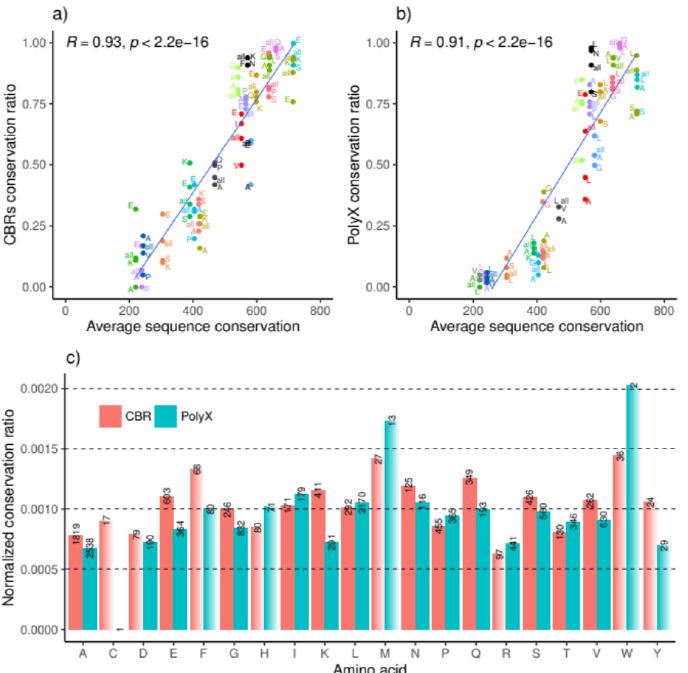
Figure 2. ( a ) CBR conservation ratio per bacterial strain pair compared to the average conservation (in bit score) of all orthologous pairs for the top three most abundant CBRs per strain pair; ( b ) polyX conservation ratio per bacterial strain pair compared to average conservation (in bit score) of all orthologous pairs for the top three most abundant polyX per strain pair; ( c ) conservation ratio for CBRs and polyX (of each amino acid type) normalized by the average conservation of the strain pair; bars with less than 100 cases are blurred. Dots for each strain pair are represented with the same color in ( a , b ) and align vertically since they have the same x-axis value; the value “all” (displayed in Figure 1b,c) is included for